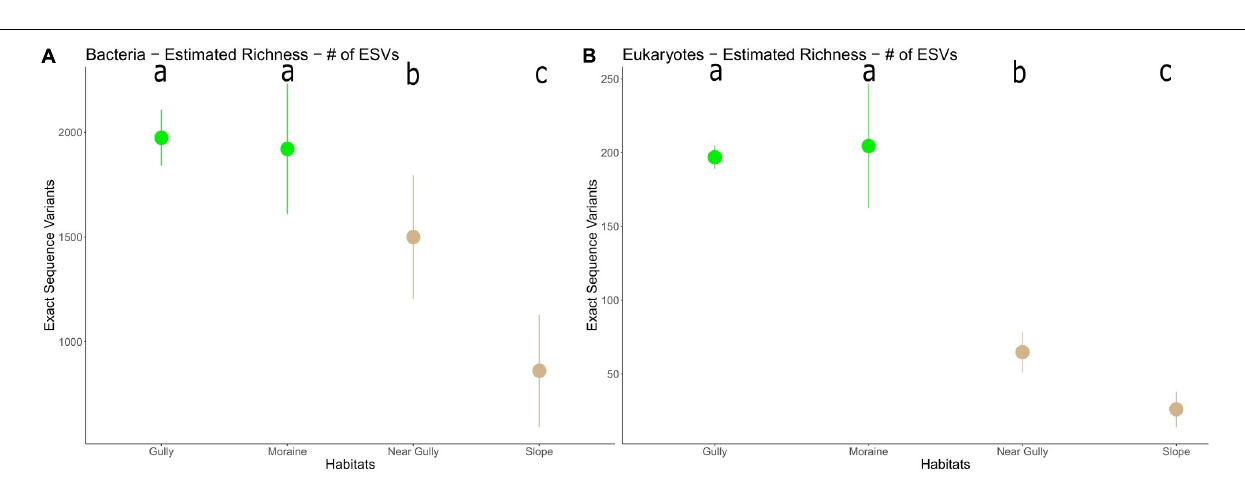
Frontiers in Microbiology |